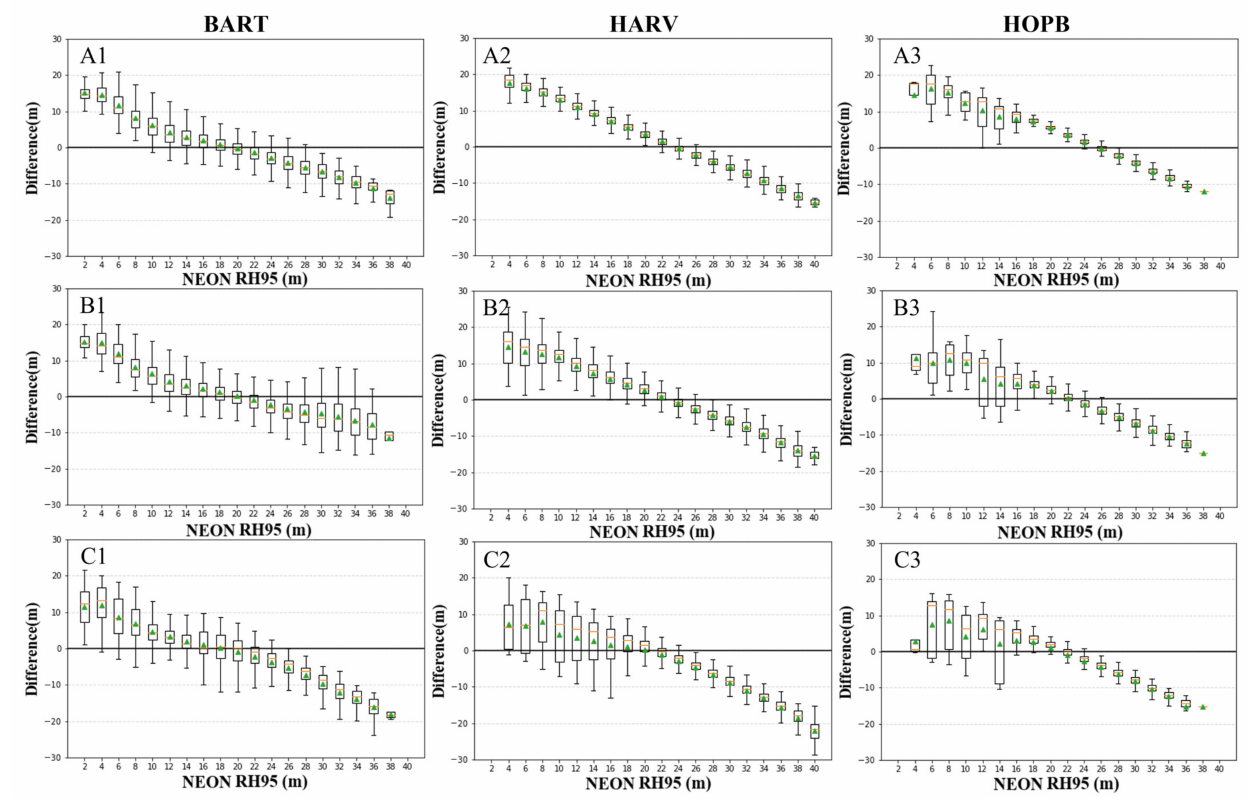
Figure A3. The residuals of the C-CH ( A1 – A3 ), RF-CH ( B1 – B3 ), and GDAL RH95 ( C1 – C3 ) among different canopy heights measured with NEON LiDAR in BART, HARV,